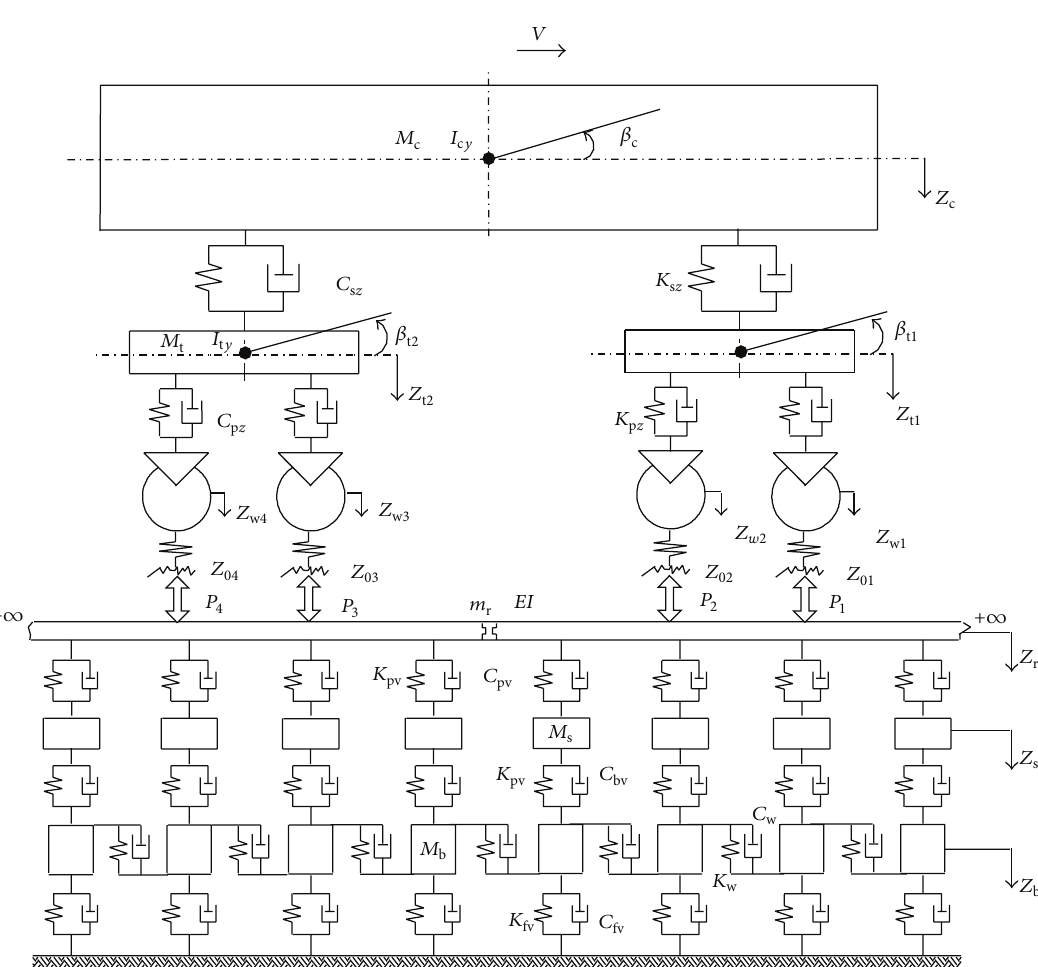
Figure 6: Three-dimensional vehicle-track coupled dynamic model